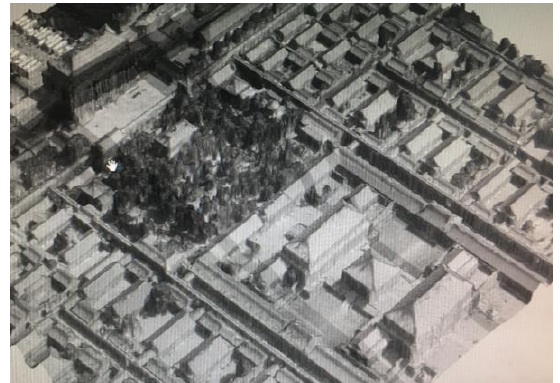
Figure 4. 3D scene model of The Imperial Palace in 1989 by the archived RC-10 aerial films with the resolution of 0.07